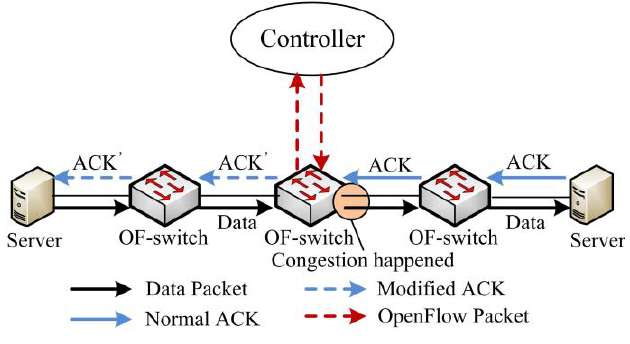
Figure 2. SDTCP overall architecture. Figure 2. The workflow of SDTCP.